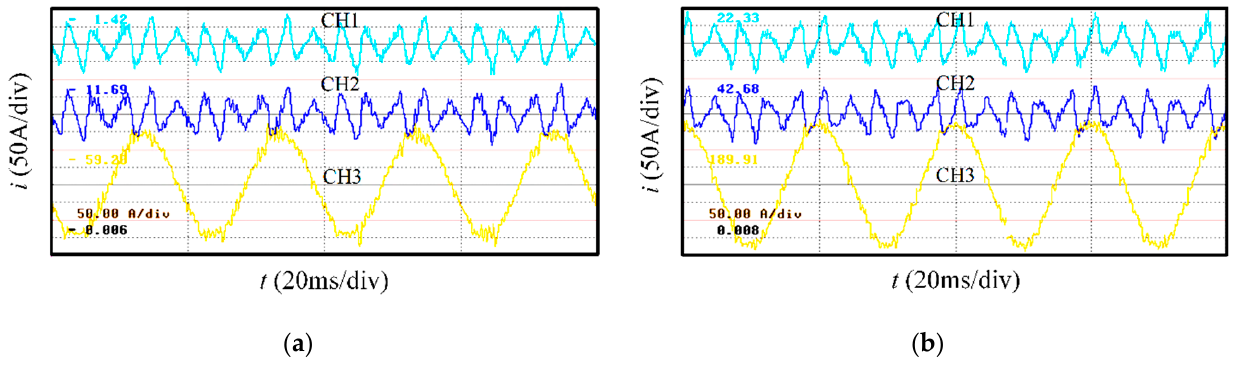
Figure 17. Experimental waveforms of virtual damping (CH1—SAPF current before LCL filter; CH2—SAPF current after LCL filter; CH3—grid current) ( a ) without virtual damping; ( b ) with virtual damping. Table 1. Performance of shunt virtual damping control.